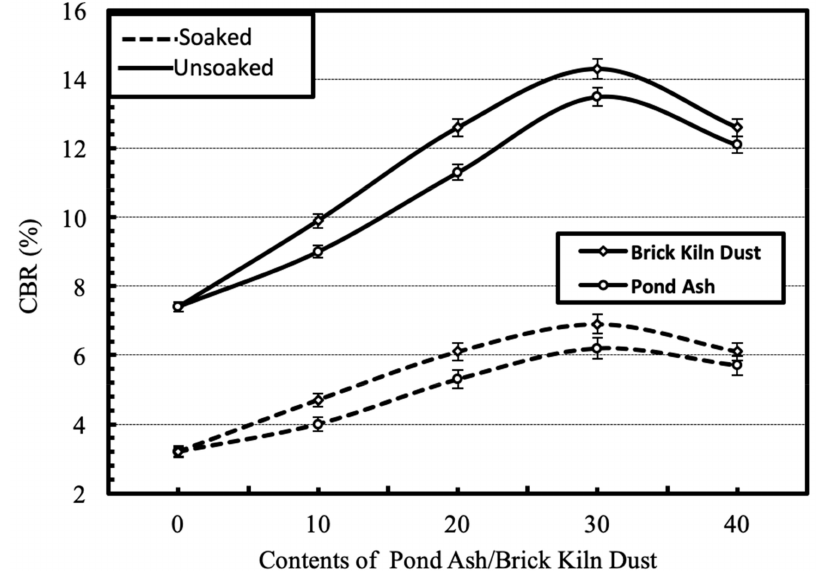
Figure 10. Variation in CBR of the geomaterial with varying contents of pond ash or brick kiln dust under soaked and unsoaked